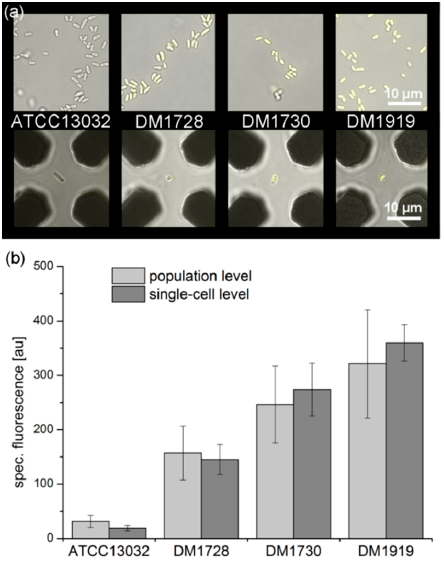
Figure 9. Specific fluorescence of L -lysine producing C. glutamicum strains (DM1728, DM1730, DM1919) and the wildtype strain C. glutamicum ATCC13032, all carrying pSenLys. ( a ) Microscopic overlays of bright field and fluorescence channel image for each strain from populations in